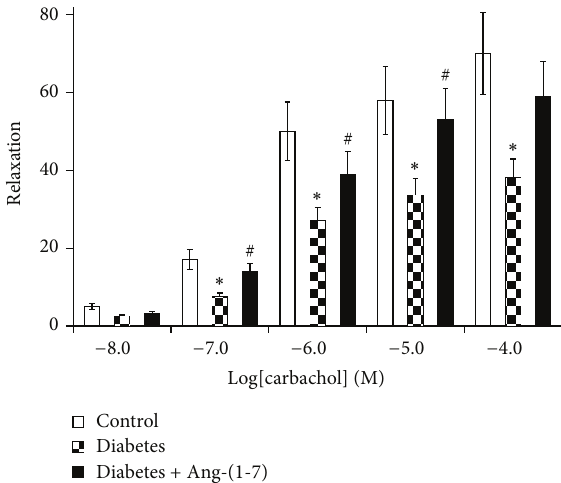
Figure 3: Carbachol-induced relaxation (expressed as %) in the corpus cavernosum segments from nondiabetic (control), diabetic, and diabetic rats treated with Ang-(1-7) (Mean ± SEM, 𝑛 = 6 – 8). Asterisk ( ∗ ) indicates significantly different mean values as compared to control, and hash (#) indicates significantly different mean values as compared to diabetes. 𝑃 < 0.05 . Tissues isolated from 6-week diabetic rats treated with Ang-(1-7) for the last three weeks of the